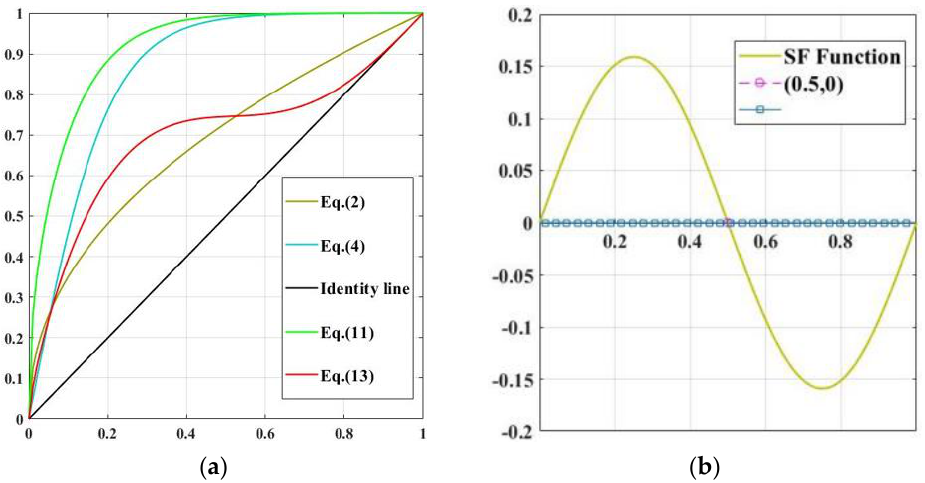
Figure 6. Different transformation function graphs. ( a ) The graphs of Equations (2), (4), (11) and (13); ( b ) Graph of the SF function.